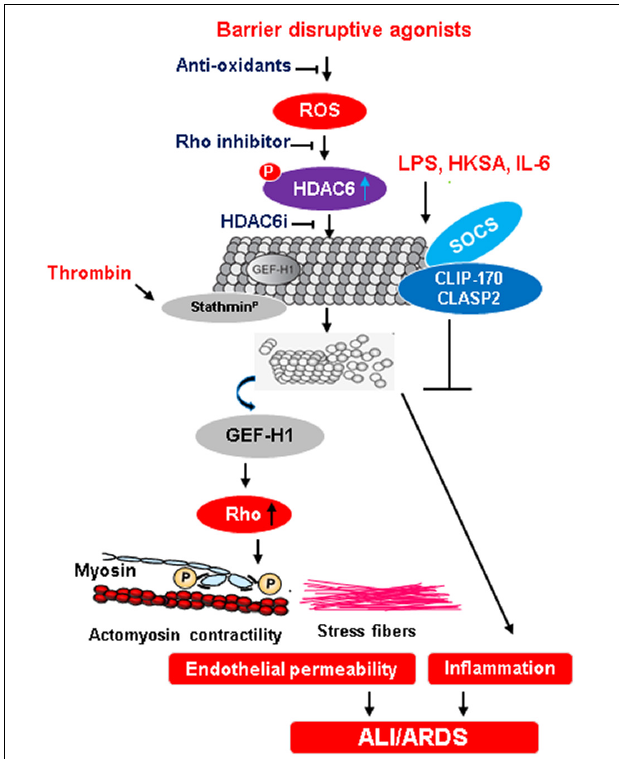
FIGURE 2 | MT-mediated regulation of endothelial barrier function during ALI/ARDS. An excessive ROS production in response to injurious stimuli activates HDAC6 by phosphorylation. In turn, activated HDAC6 deacetylates tubulin causing the destabilization of MT and release of Rho-specific GEF-H1. The activation of Rho signaling pathway induces cytoskeletal remodeling with increased actomyosin contractility and stress fibers formation that leads to an increase in endothelial permeability, a trigger for ALI and ARDS. Anti-oxidants and inhibition of Rho as well as HDAC6 presents points of potential therapeutic interventions to prevent endothelial dysfunction-derived lung injuries. Dephosphorylation of stathmin by thrombin also contributes to MT destabilization and subsequent endothelial dysfunction. Conversely, the formation of a protein complex between SOCS and MT plus-end-tracking proteins CLIP-170 and CLASP2 exerts anti-inflammatory effects on